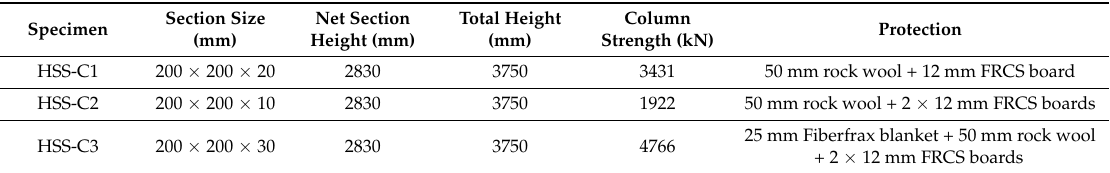
Table 1. Column specimens for fire resistance